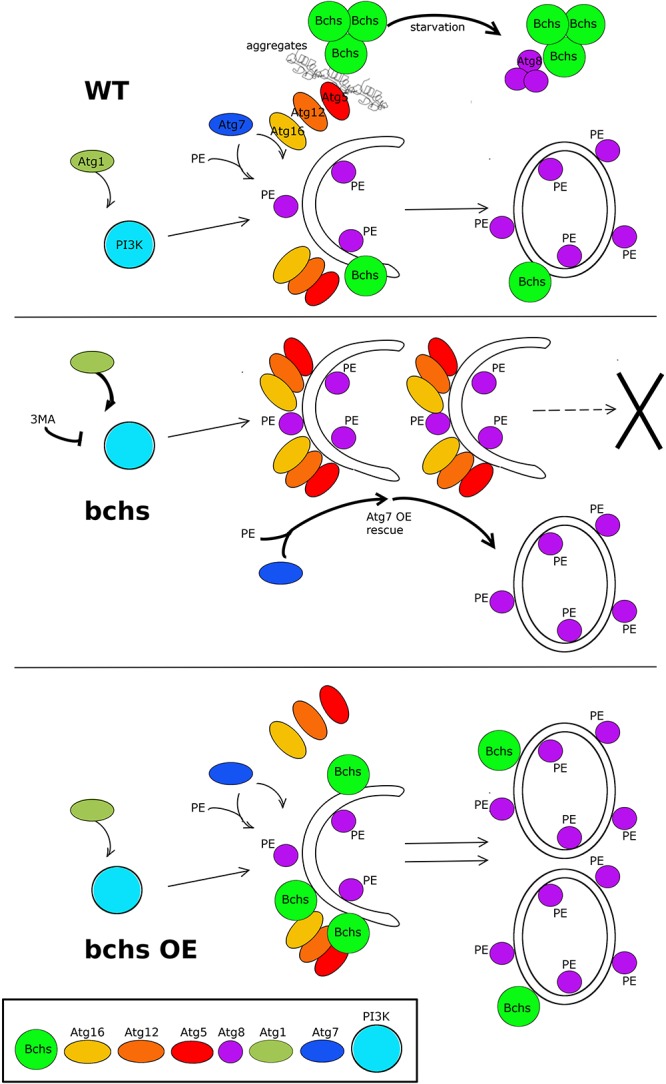
Schematic model of the possible relationship of Bchs and the autophagy pathway in the clearance of aggregated proteins and Atg8-carrying vesicle production. In the wild type situation (top), Bchs associates preferentially with Atg5 during the induction of aggrephagy (squiggly lines), and this association is suppressed by starvation-induced autophagy, wherein Bchs colocalizes more with Atg8. In the bchs case (middle), full maturation to Atg8-marked vesicles is reduced (—>X), and this is epistatic to upstream PI3K activation or inhibition by Atg1 or 3MA, but can be overcome by over-expressing Atg7 (thick arrows). Bchs over-expression (bchs OE; bottom) drives the maturation of autophagic vesicles to the Atg8-marked stage.